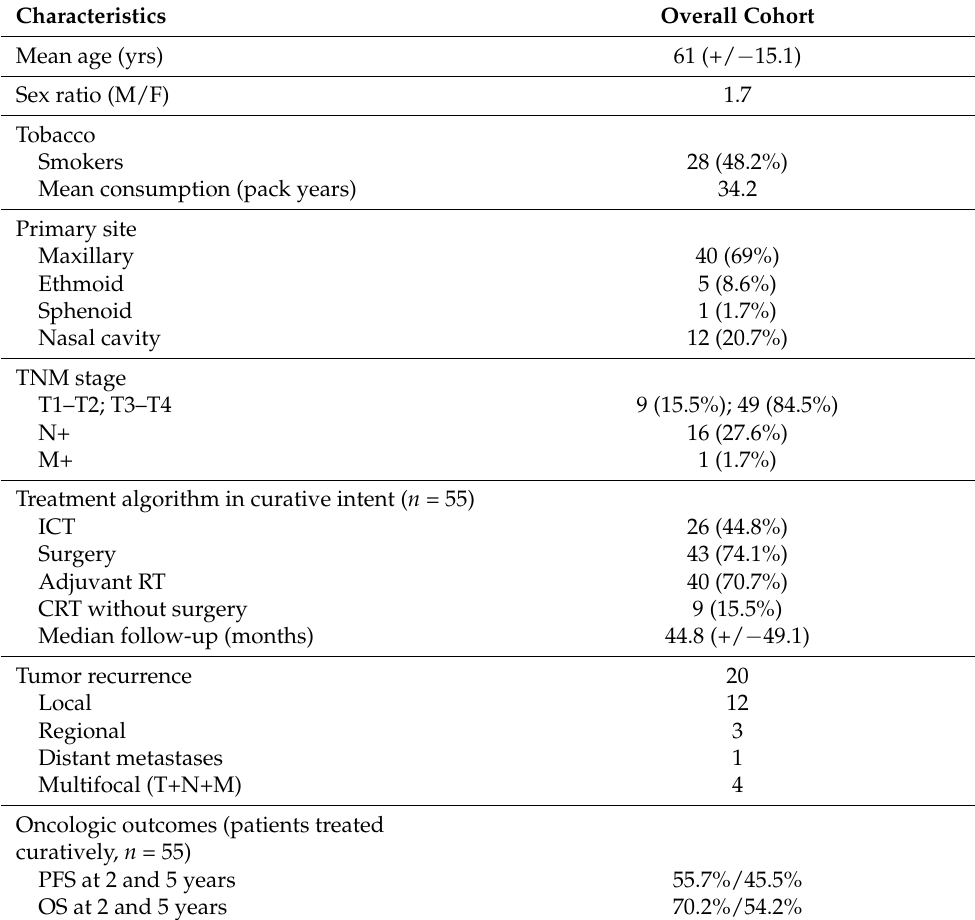
Table 1. Patient and tumor